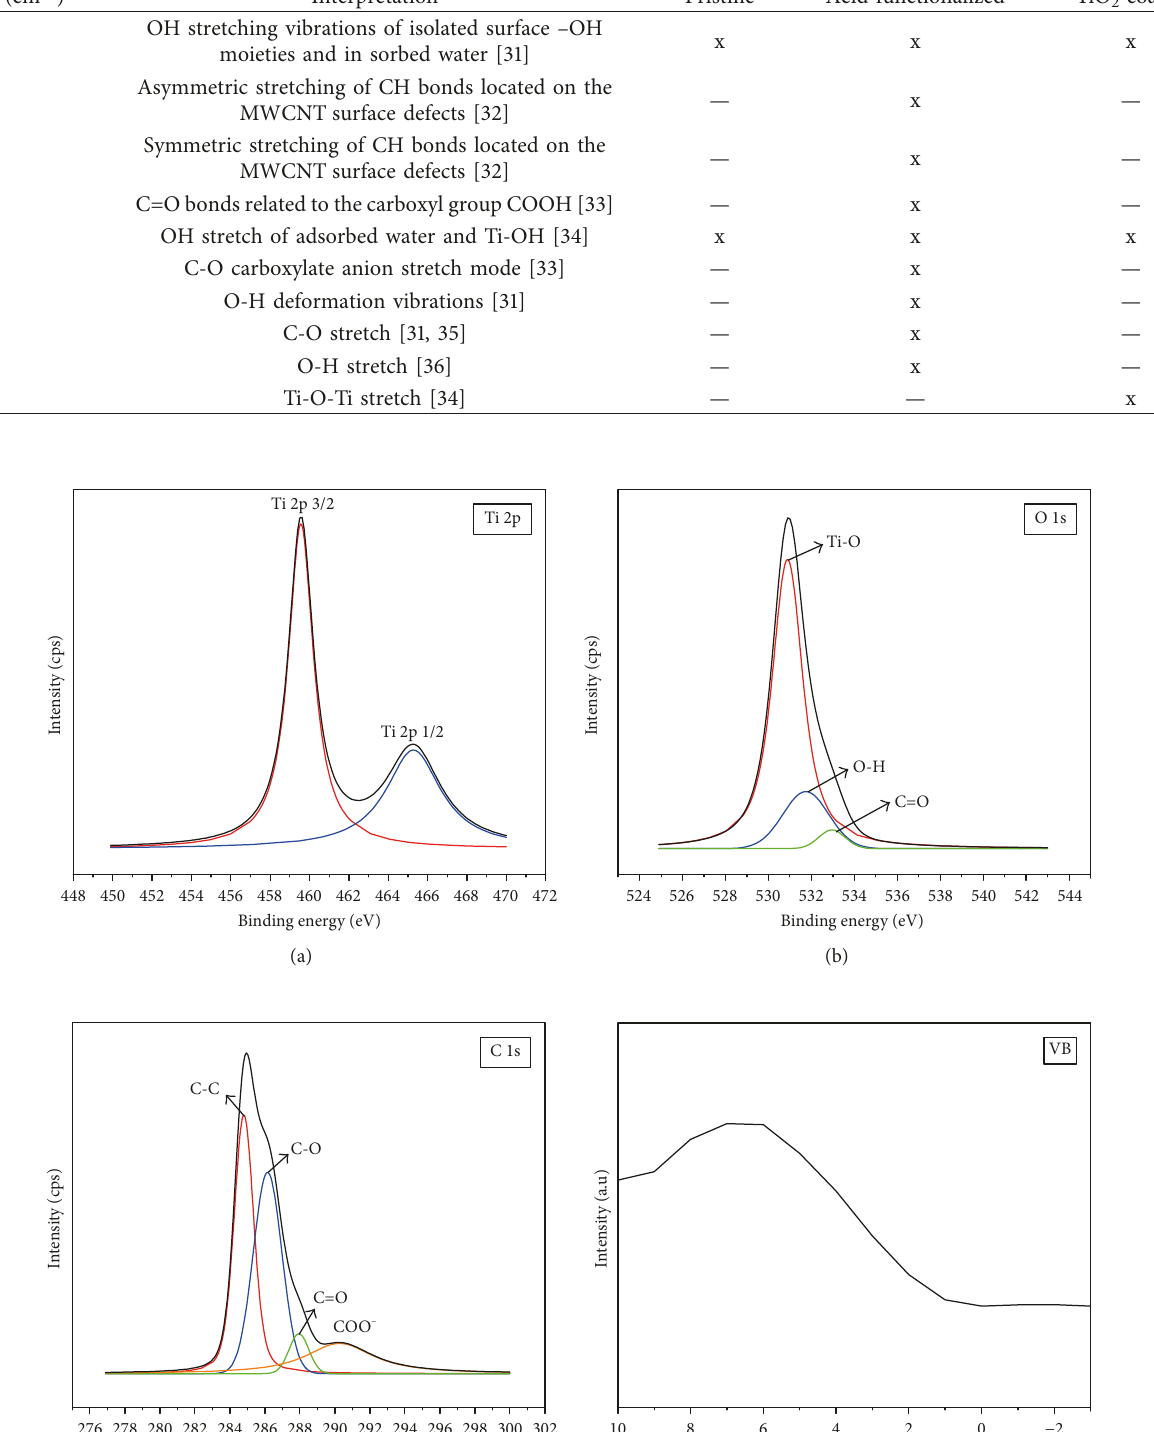
2 -coated MWCNTs with II coating